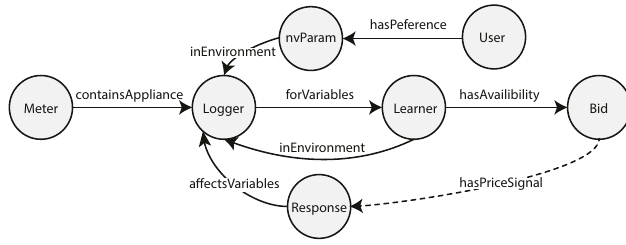
Fig. 4. Knowledge based ontology used for representing functional blocks within the Flexometer and their relationships.